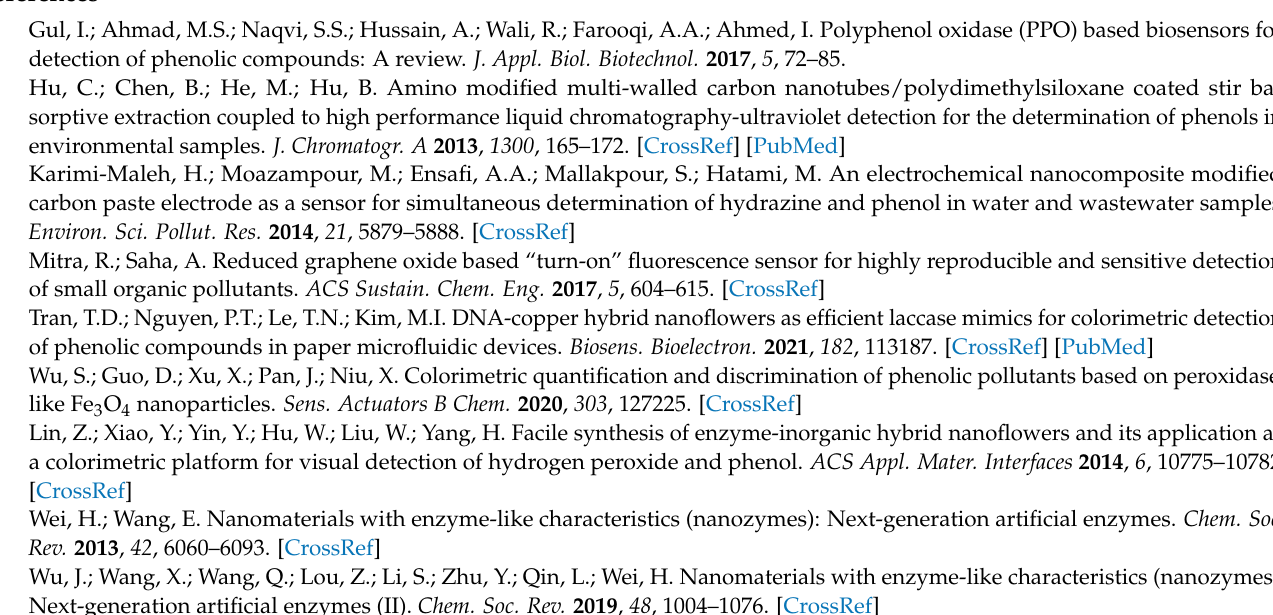
Nature, Figure S2: XRD patterns for MgAC-Fe 3 O 4 /TiO 2 , MgAC-Fe 3 O 4 , and MgAC-TiO 2 , Figure S3: XPS full-survey spectra for (a) MgAC-Fe 3 O 4 /TiO 2 , (b) MgAC-Fe 3 O 4 , and (c) MgAC-TiO 2 , Figure S4: XPS spectra for (a) Fe 2p and (b) Ti 2p of MgAC-Fe 3 O 4 /TiO 2 ; (c) Fe 2p of MgAC-Fe 3 O 4 ; and (d) Ti 2p of MgAC-TiO 2 , Figure S5: Steady-state kinetic assays of MgAc-Fe 3 O 4 /TiO 2 for H 2 O 2 and ABTS in the (a) presence and (b) absence of UV-light irradiation, and their corresponding Lineweaver-Burk plots, Figure S6: Reusability of MgAc-Fe 3 O 4 /TiO 2 hybrid for pyrocatechol determination, Table S1: Kinetic parameters of MgAc-Fe 3 O 4 /TiO 2 with and without UV-light irradiation, Table S2: Comparison of CVs and recovery values of MgAc-Fe 3 O 4 /TiO 2 -based assay for phenolic compounds with those of previous nanomaterial-based